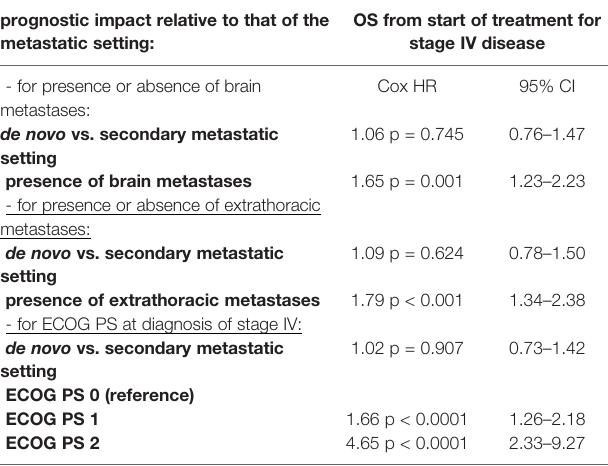
TABLE 3 | Relative effect of the de novo vs. secondary setting, compared to the effect of metastatic pattern and ECOG performance status on overall survival of EGFR + lung cancer patients.